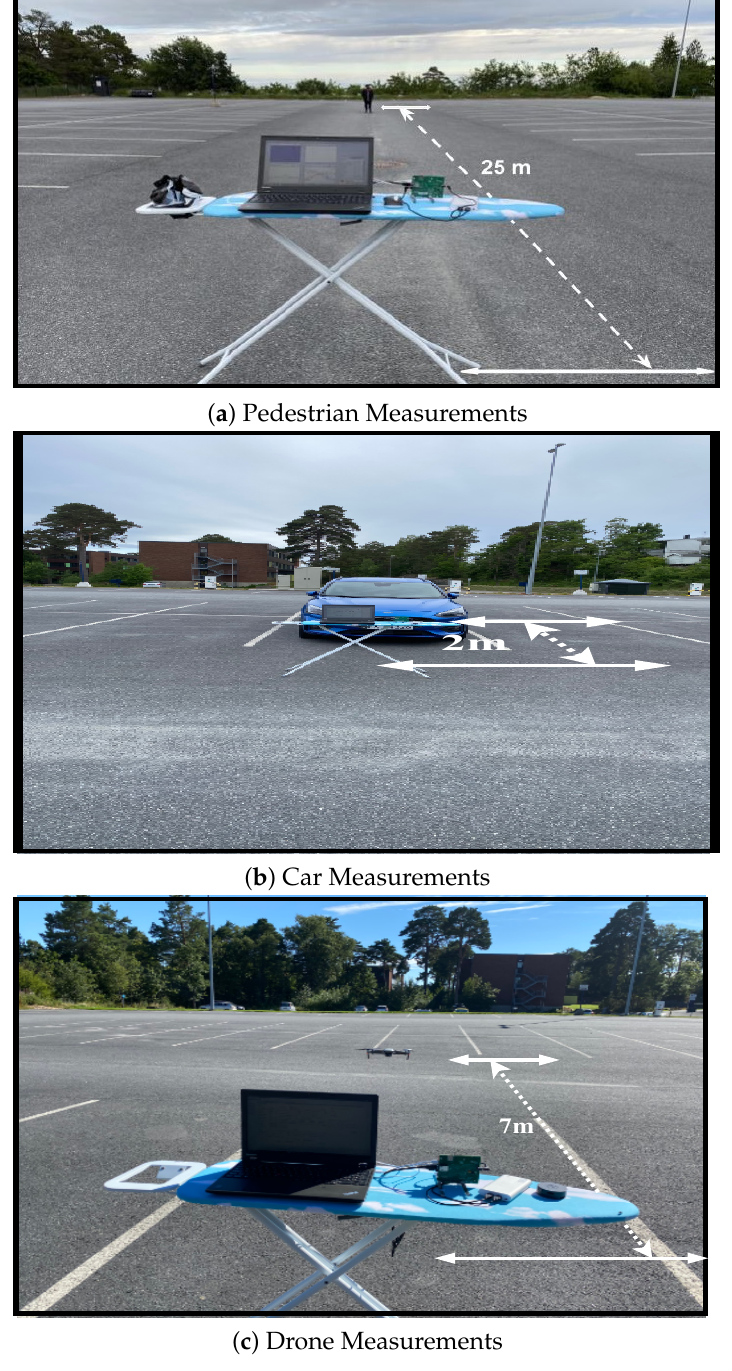
Figure 6. Measurement